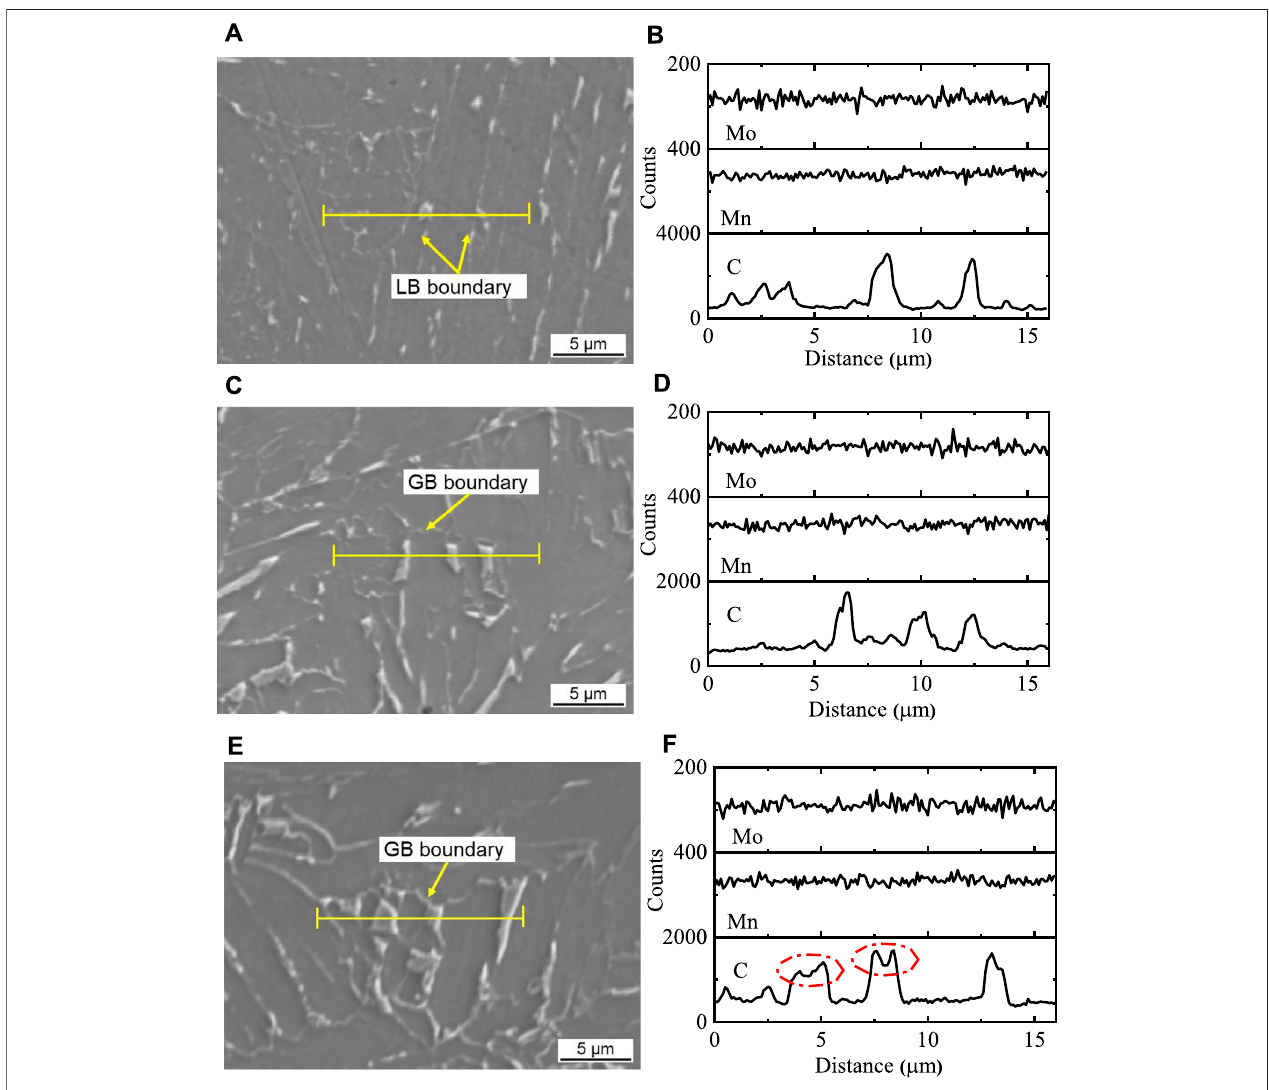
FIGURE7| SEMmorphologiesandcarbonpro fi lesofM – Aconstituentsorcarbidesattheheatinputof100 kJ/cm (A,B) ,150 kJ/cm (C,D), and200 kJ/cm (E,F) .